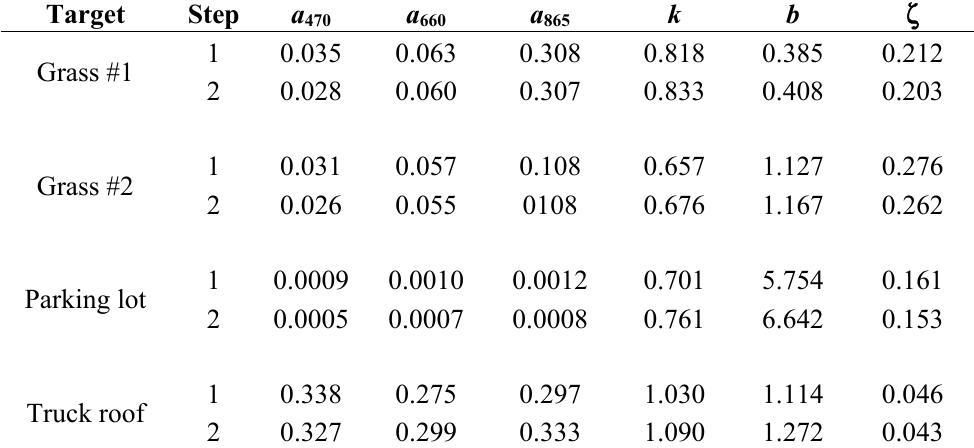
Table 1. Fitted model parameters during Steps 1 and 2 of the fitting